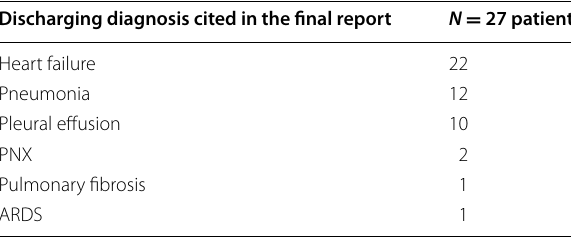
Table 6 Summary of the final discharging diagnosis (for some patients two or more diagnosis were